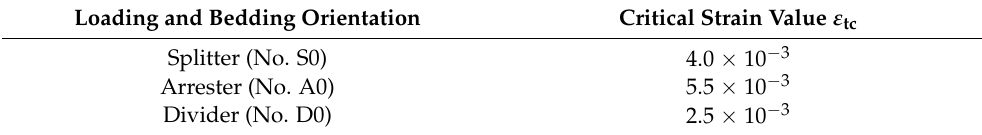
Table 3. The critical strain value of shale failure measured by the non-cracked compression test. Loading and Bedding Orientation